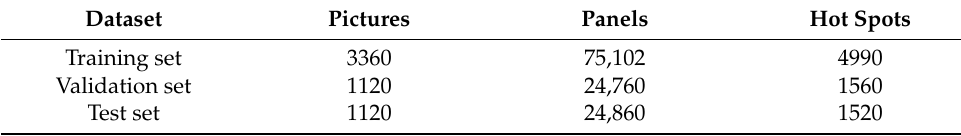
Table 1. Infrared photovoltaic image